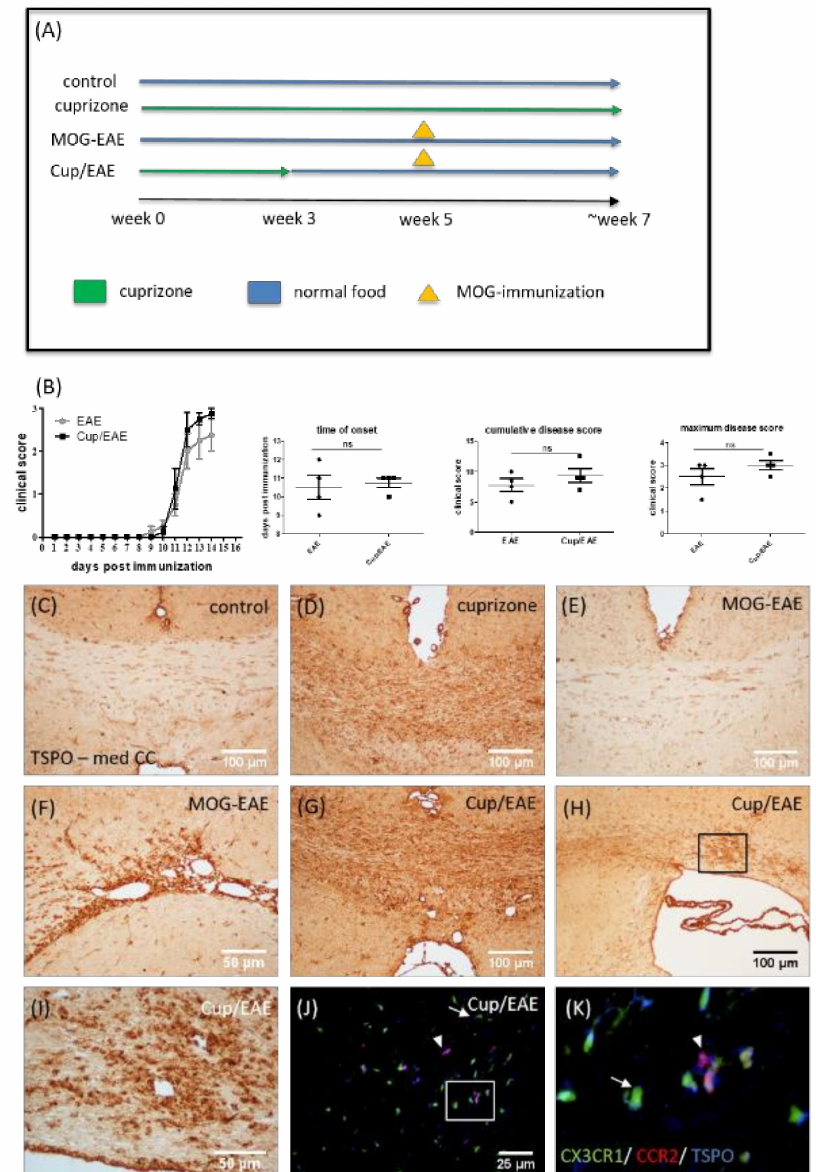
Figure 8. Expression of TSPO in Cup/EAE mice ( A ). Schematic depicting the experimental setup. The periods of normal chow diet are highlighted in blue. The periods of cuprizone intoxication are highlighted in green, and the time point of MOG 35–55 immunization with subsequent active EAE development are highlighted in orange. ( B ) The clinical scores for MOG-EAE and Cup/EAE treated mice with the time of onset, cumulative disease score and maximum disease score ( n = 4). The representative images of anti-TSPO immunohistochemistry in the controls ( C ), cuprizone-intoxicated ( D ), MOG-EAE ( E , F ), and Cup/EAE ( G – I ) mice. The perivascular lesion, highlighted in ( H ) by the black box, is shown in ( I ) at higher magnification. ( J , K ) The representative images of the corpus callosum from cuprizone-treated mice, showing microglia (green), infiltrating monocytes (red) and TSPO (blue). The arrow indicates TSPO expression in microglia cells, and the arrowhead indicates TSPO expression in invaded